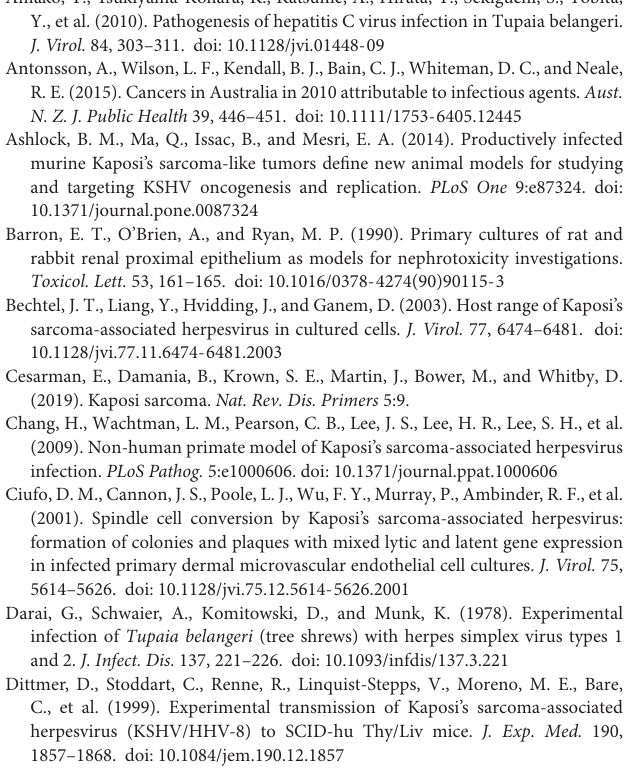
Supplementary Table 1 | Primers for RT-PCR amplification. Supplementary Table 2 | GFP and RFP positive cells in rKSHV.219-inoculated cultures of TSKEC, TSH, TSVEC, TSPBMCs, TSLEC, and HEK293 at 48 h post-infection by flow cytometry.